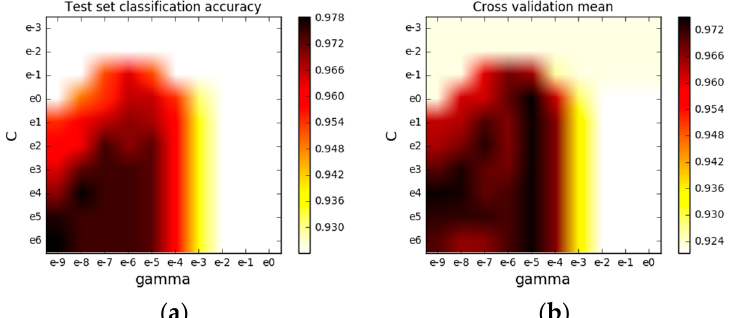
Figure 11. Selection of parameters C and σ in two categories: ( a ) Test set classification accuracy; ( b ) Cross validation mean.